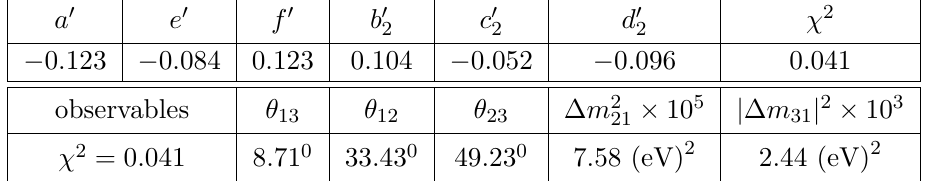
1 , namely ( M ) = 5 : 27 (cid:2) 10 11 GeV and 1 1 lower . A plot of Y vs M 1 B B